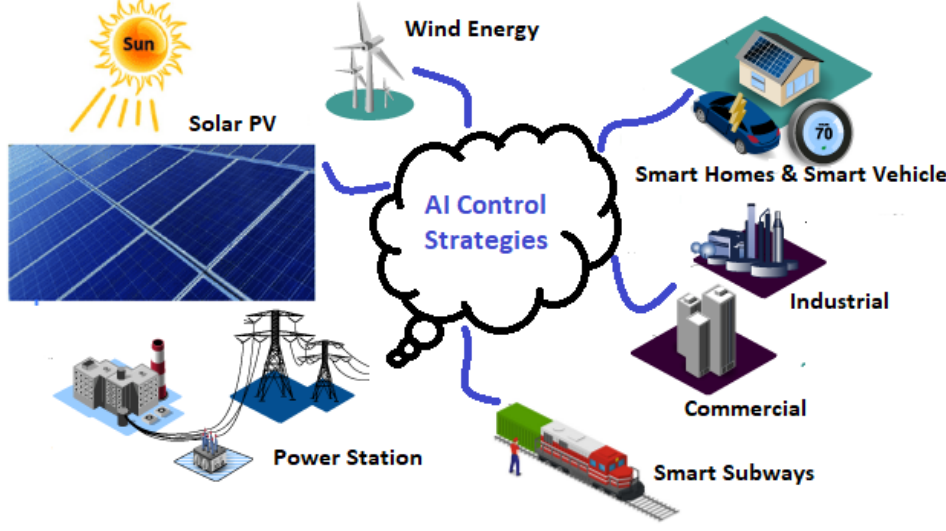
Figure 1. Smart grid AI control schemes.